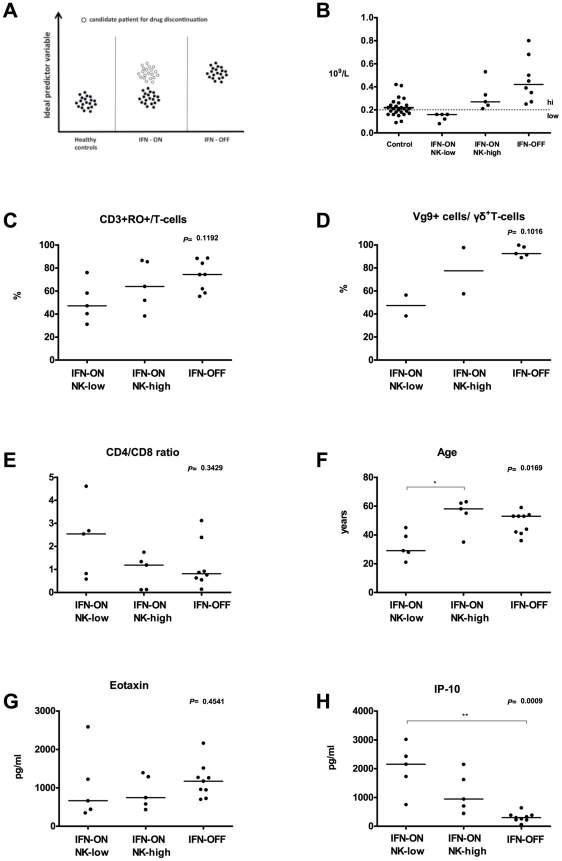
Characteristics of a predictor variable for IFN-α discontinuation.A. Example of a hypothetical variable differentiating patients who can stop IFN-α therapy (empty circle) from those who cannot in the IFN-ON group. B. NK-cell count as a potential predictor variable. The figure presents absolute NK-cell numbers in different patient groups. Patients still using IFN-α therapy were divided in 2 groups based if their absolute NK-cell count was above (IFN-ON NK-high) or below (IFN-OFF NK-low) 0.2×109/l. C–H. Biomarker profile of NK-high and NK-low groups. Patients using IFN-α therapy (IFN-ON) were divided in 2 groups based on the absolute NK-cell count in the peripheral blood. In NK-high group, the absolute NK-cell count was above 0.2×109/l and in NK-low group below the given limit. Other variables are presented based on the group division by NK-cell number and IFN discontinued patients as a separate cohort (IFN-OFF).